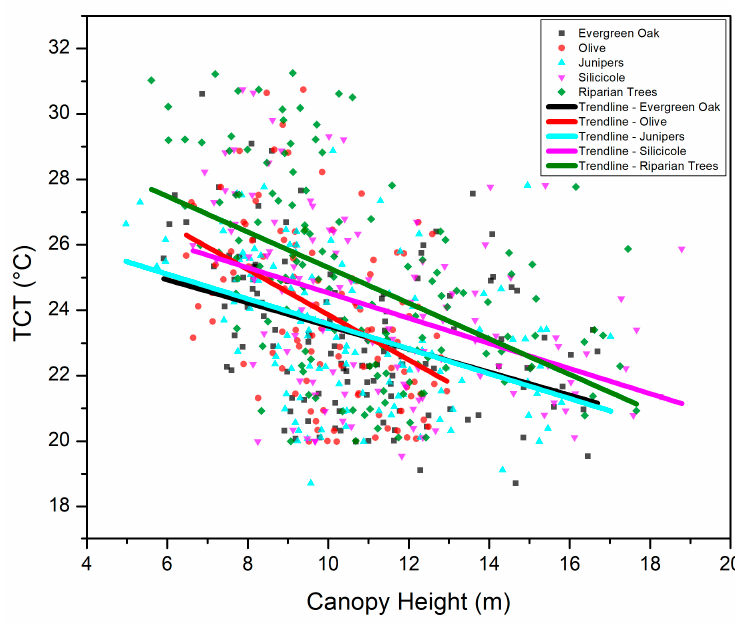
Figure 10. Scatter plot of tree canopy temperature (TCT) vs. canopy height for the five prevailing vegetation types (evergreen oak trees, olive trees, junipers, silicicole, and riparian trees) in the study area.